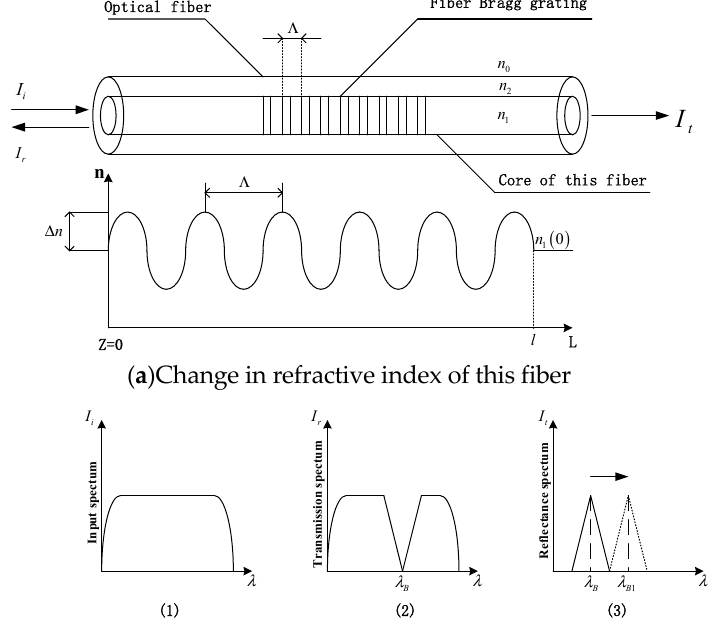
Figure 1. The structure and spectral characteristics of FBG. ( a ) I i is the incident light intensity that is incident into FBG. I r is the reflected light intensity reflected by FBG. I t is the transmitted light intensity through FBG. Λ is the grating period. ( b ) (1) represents the incident spectrum of the incident into FBG. (2) represents the transmission spectrum through FBG. (3) represents the reflected spectrum reflected by FBG. λ B is the wavelength of the reflected wave. λ B 1 represents the wavelength of the reflected wave after the fiber grating is externally affected.